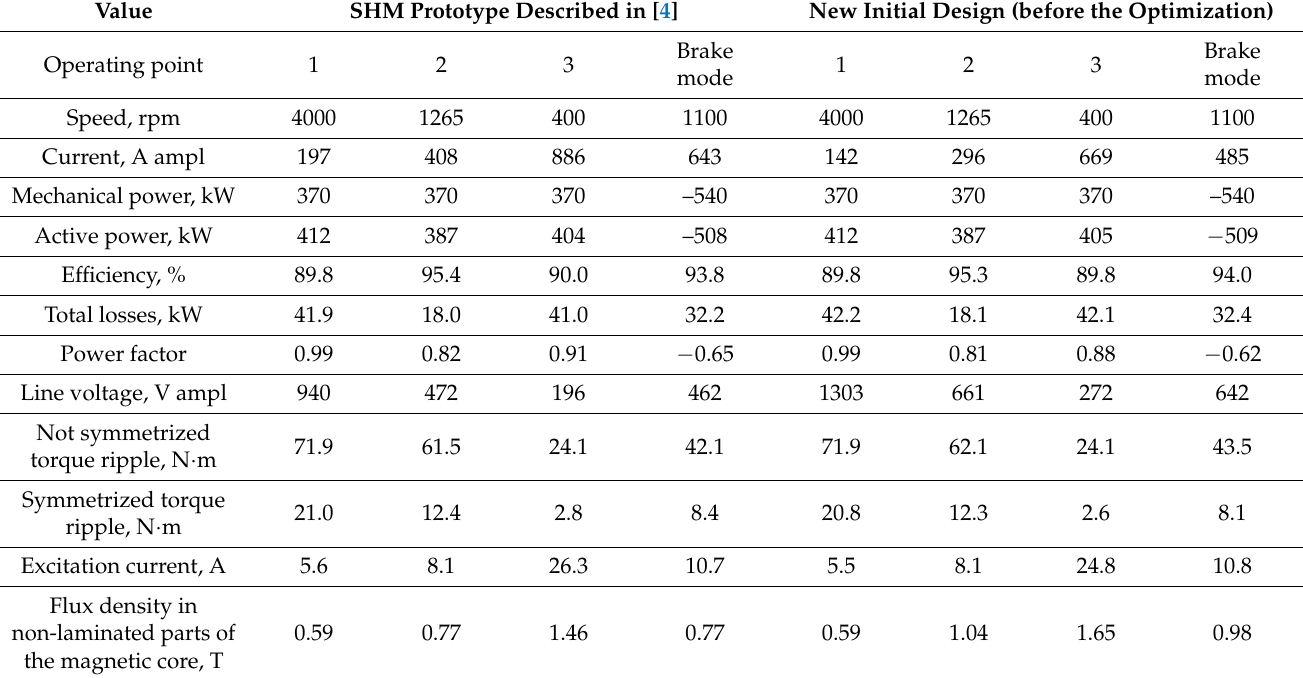
Table 5. Comparison of the characteristics of the SHM prototype described in [4] and the characteristics of the new initial design used as the starting point for the